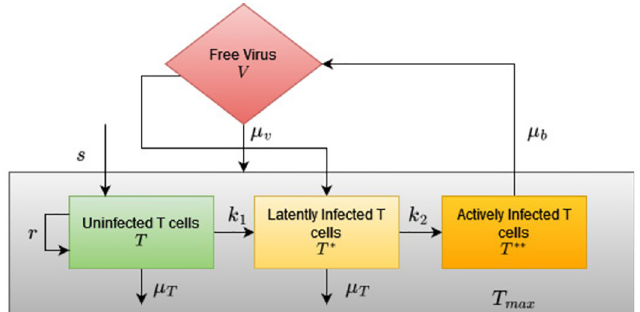
Fig 9. The model for infection of HIV on CD4++ T-cells. T - uninfected T cells, T � latently infected T cells, T �� - actively infected T-cells and V - free virus. The parameters include s —the rate of supply/production of CD4+ T-cells, μ T —the death rate of uninfected and latently infected T cells. r - the rate of growth of CD4+ T cell population, k 1 -rate at which CD4+ T cells become infected, k 2 —the rate at which latently infected T cells become actively infected, μ b -death number of free cells produced by lysing a CD4+ T-cell, μ —the death rate of the free rate of actively infected T cells, N v v virus, T max —total number of T